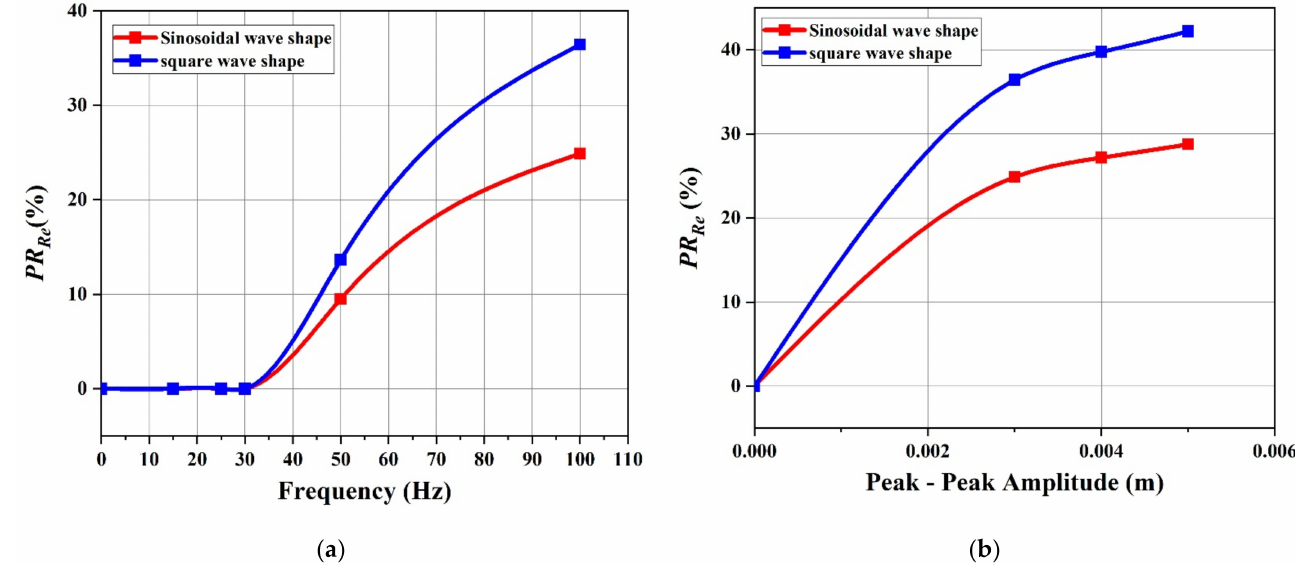
Figure 12. Variation in percentage reduction in Reynolds number with vibrational parameters: ( a ) frequency at constant Amp = 0.003 m; ( b ) peak-to-peak amplitude at constant f = 100